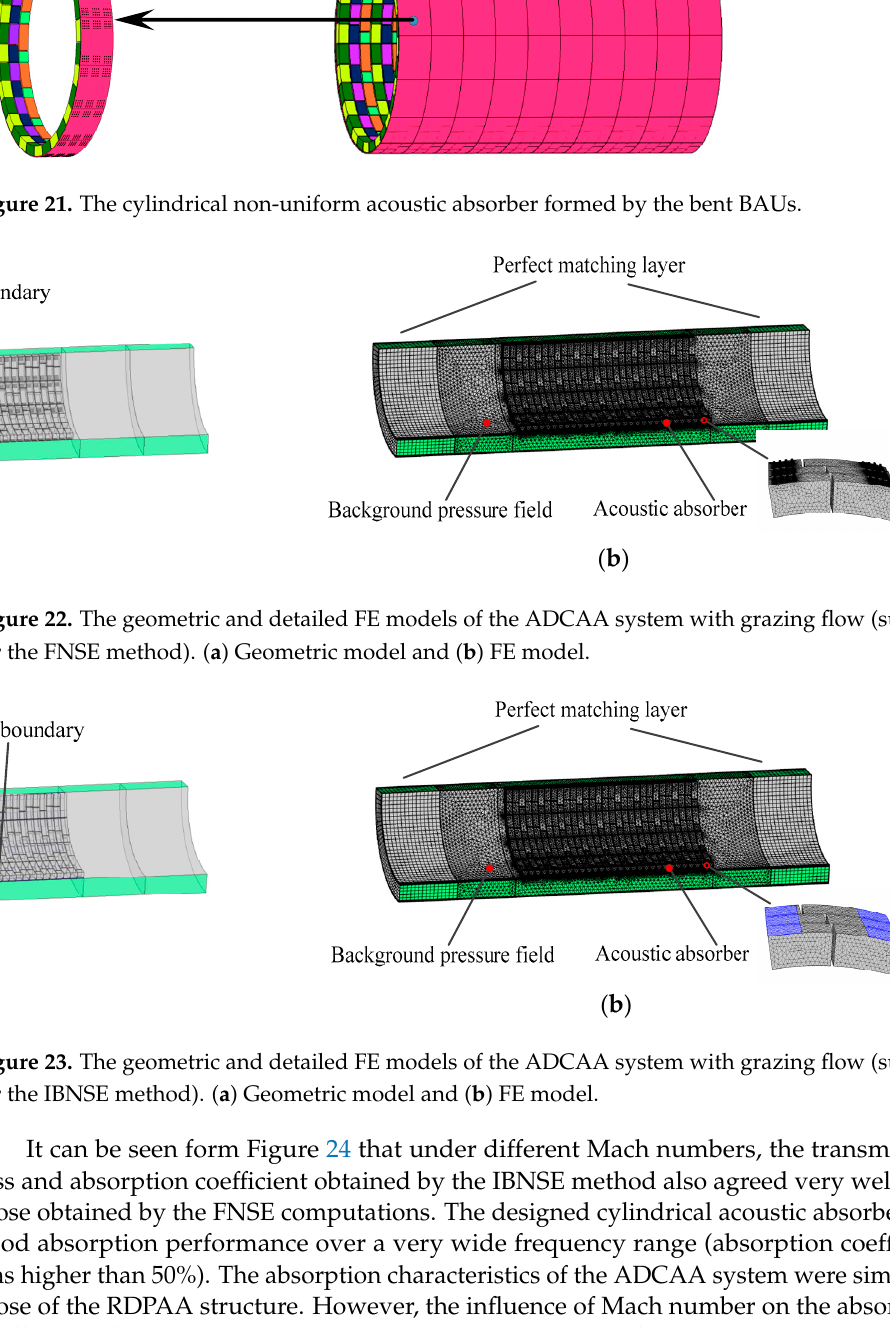
( b ) Figure 24. Transmission loss and absorption coefficient of the ADCAA system under different graz- ing flow Mach numbers. The solid lines represent the results computed by the IBNSE method with Goodrich model, while the circles represent the results computed by the FNSE method. ( a ) trans- mission loss. ( b ) acoustic absorption coefficient. In terms of the manufacturing of the absorber proposed in this paper, titanium alloy materials can be used for manufacturing if the application scenario involves high temper- atures or high stress. If the above cases are not involved, ABS (acrylonitrile butadine sty- rene) materials can be used to save costs. The whole structure can be fabricated by 3D printing. 5. Conclusions In this paper, a broadband BAU absorber was first constructed by using an MPP and backed cavities with dissimilar lengths to produce peak absorption at multiple frequen- cies. Since each cavity length is extended along the MPP surface, different cavity volumes